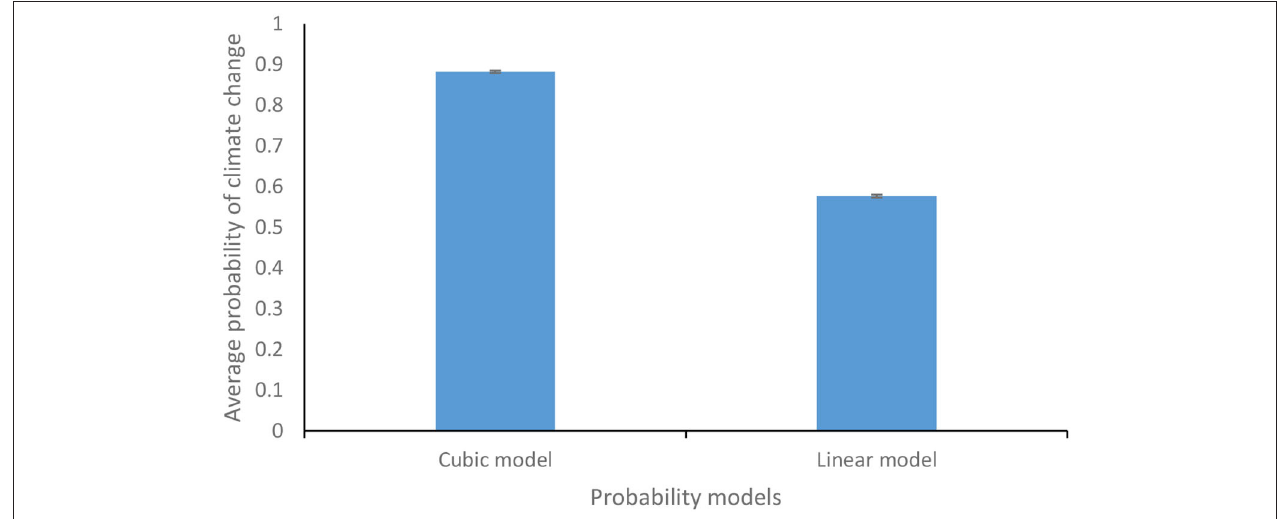
FIGURE 3 | Average probability of climate change for the cubic and the linear functions. The error bars show 95% CI around the point